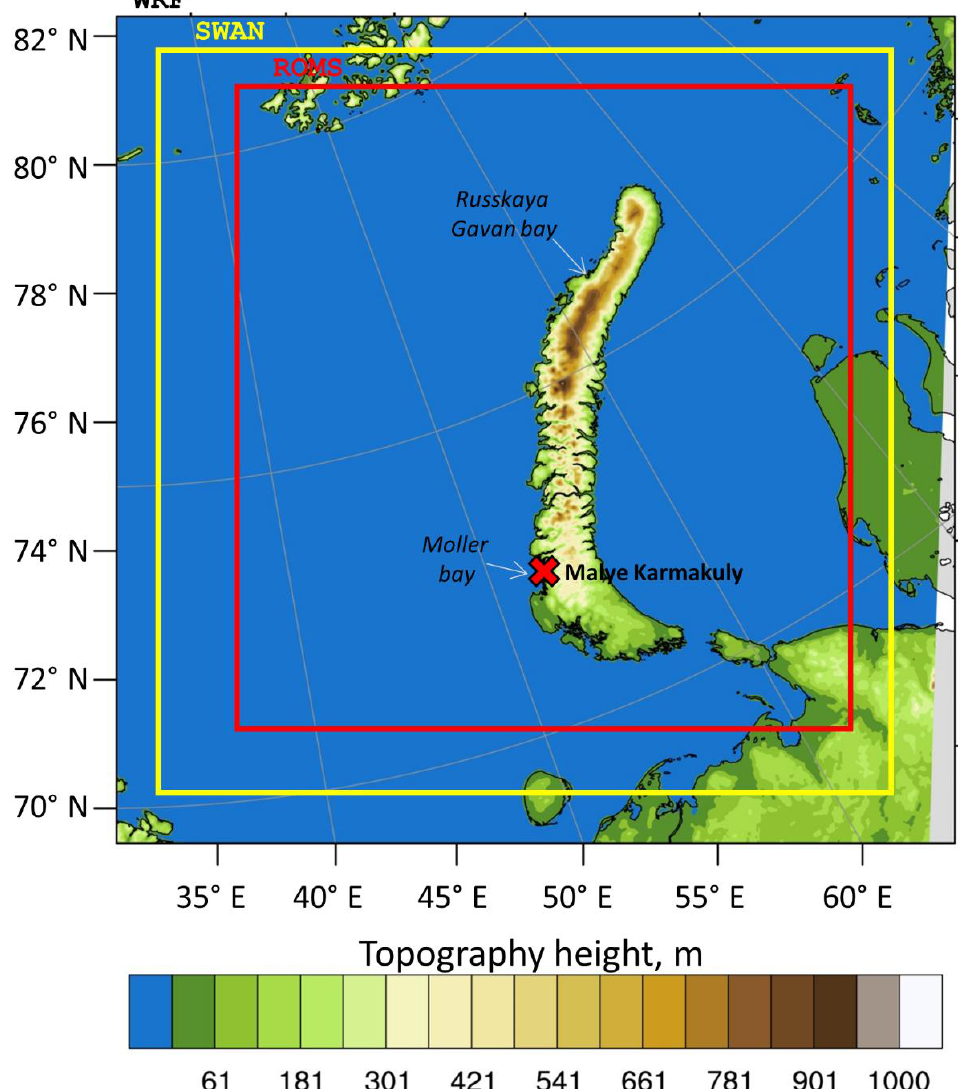
Figure 1. Coupled model domains: WRF (coincides with the boundaries of the map), SWAN (yellow rectangle) and ROMS (red rectangle). Color shows topography height (m). X-mark shows the location of the weather station.